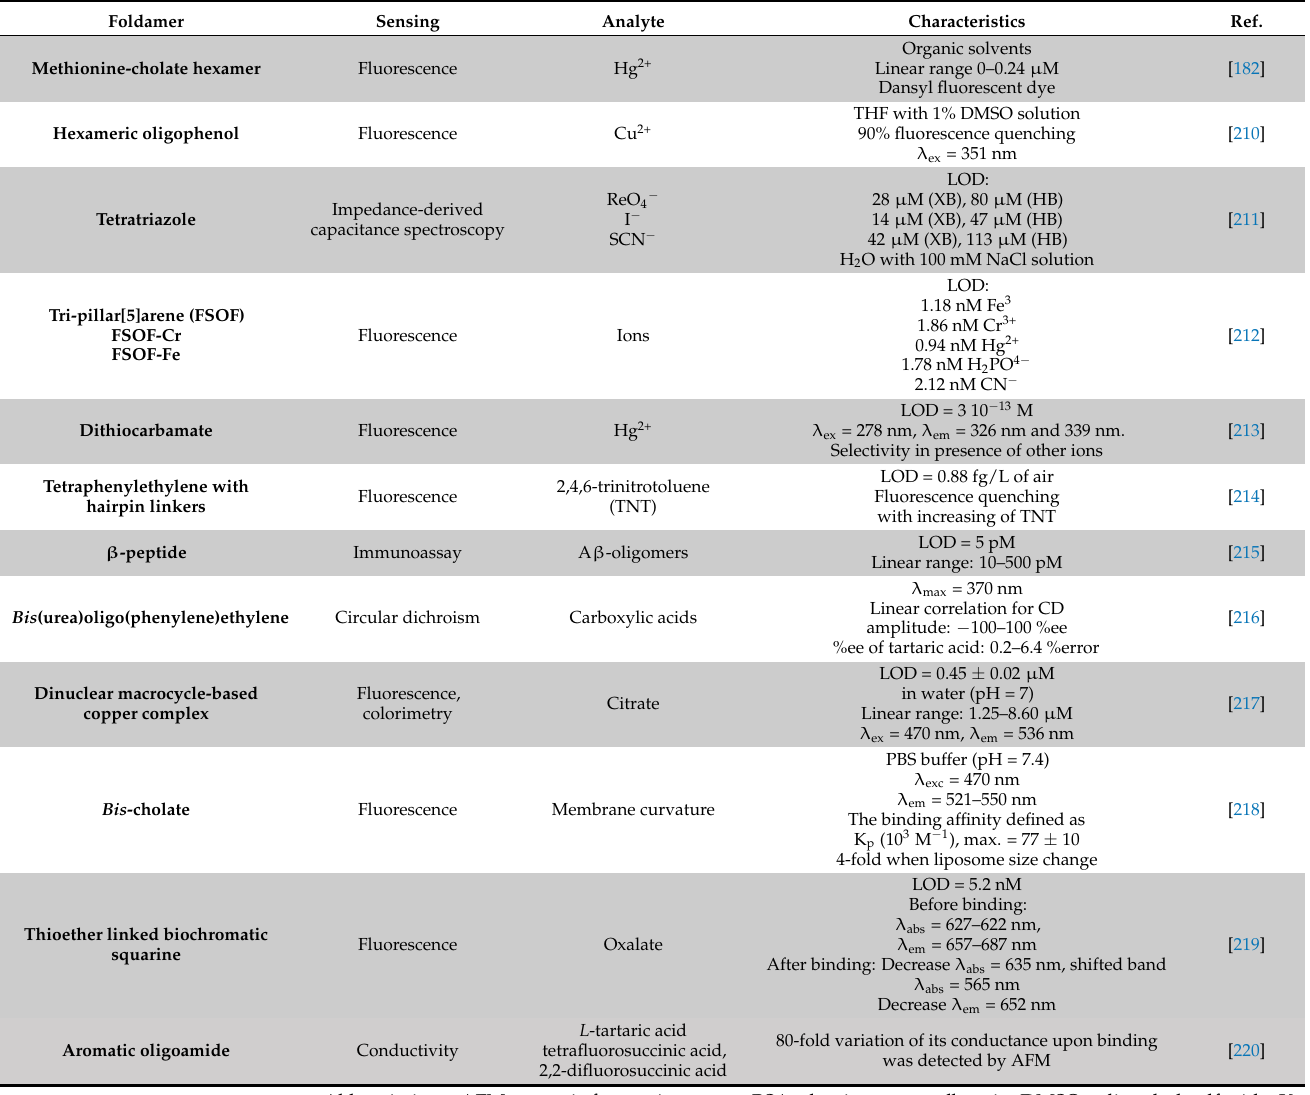
Table 3. Foldamer-based